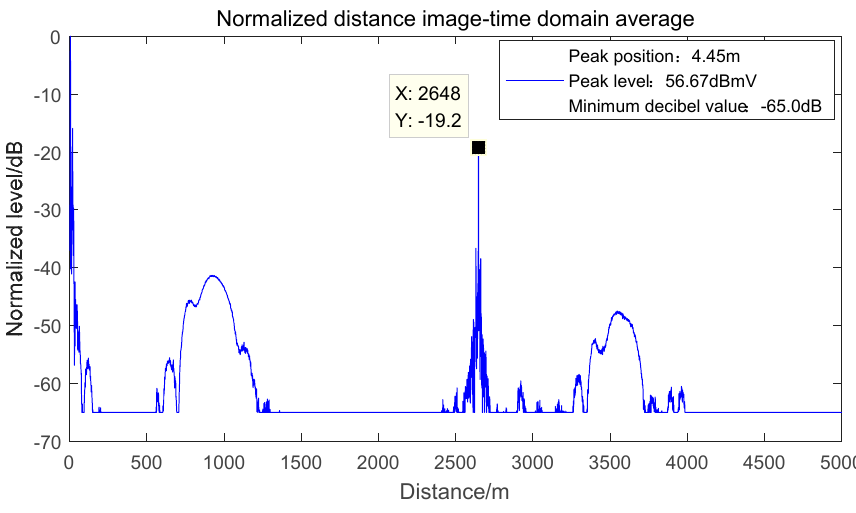
Figure 5. One-dimensional range profile of second-order intermodulation false alarm signal. Table 5. Second-order intermodulation signal position under different frequency offset.